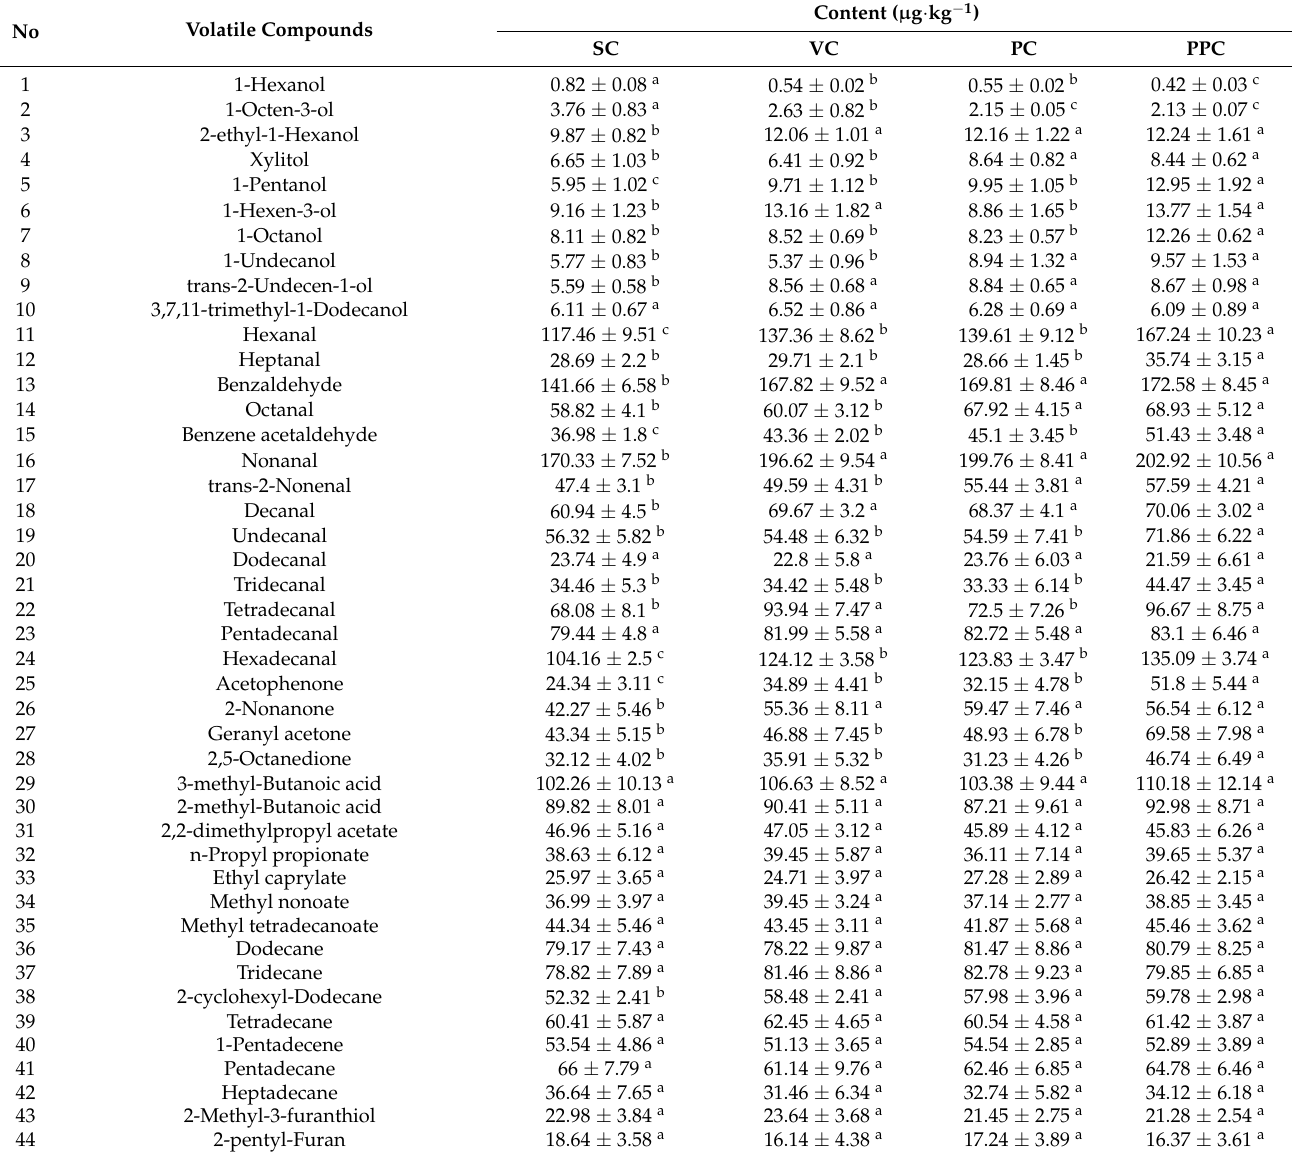
Table 3. Contents of volatile compounds on beef with different curing